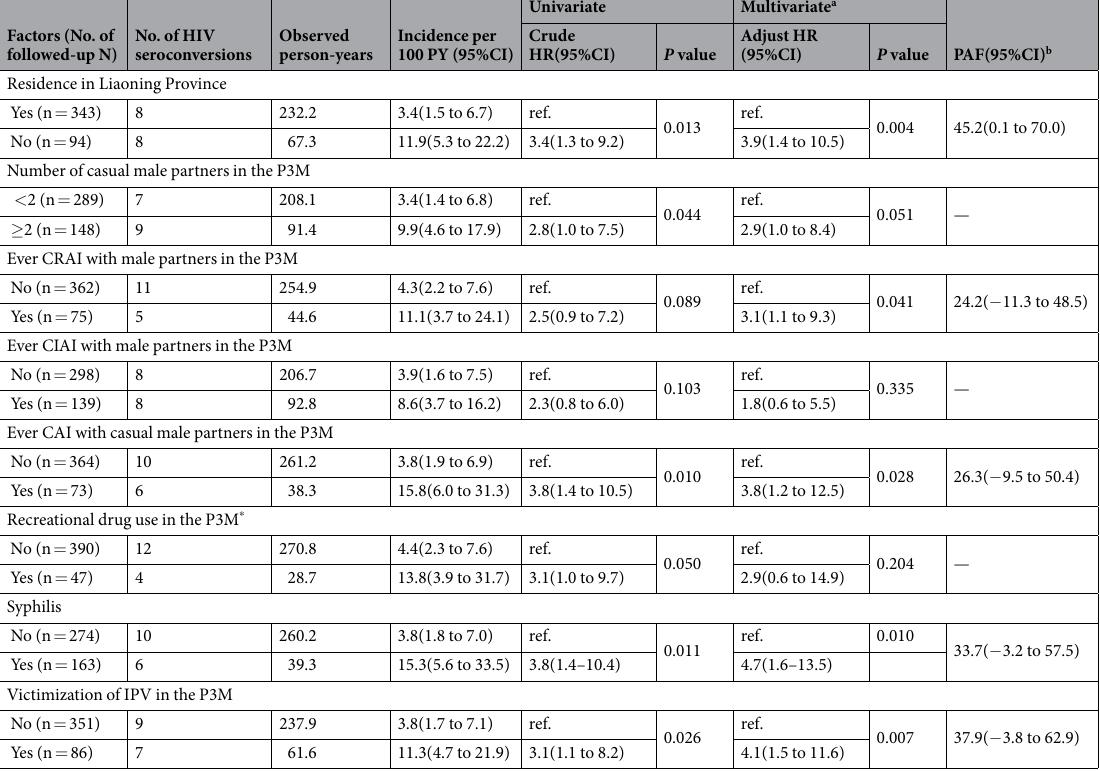
Table 3. Univariate and multivariate COX regression with time-varying covariates and population attributable fraction analysis for risk factors of HIV seroconversion in participating MSM (N = 437). Abbreviations: PY = person-years, CI = confidence interval, HR = hazard ratio, PAF = population attributable fraction, P3M = past 3 months, CAI = condomless anal intercourse, CRAI = condomless receptive anal intercourse; CIAI = condomless insertive anal intercourse. a Variables (p ≤ 0.20) was calculated by multivariate analysis after adjusting for age, marital status, educational level, and average month income. b Variables (p ≤ 0.05) was calculated by population attributable fraction. * Recreational drug included rush (poppers or alkyl nitrites), ice, amphetamines, MDMA (“ecstasy”), tramadol, and